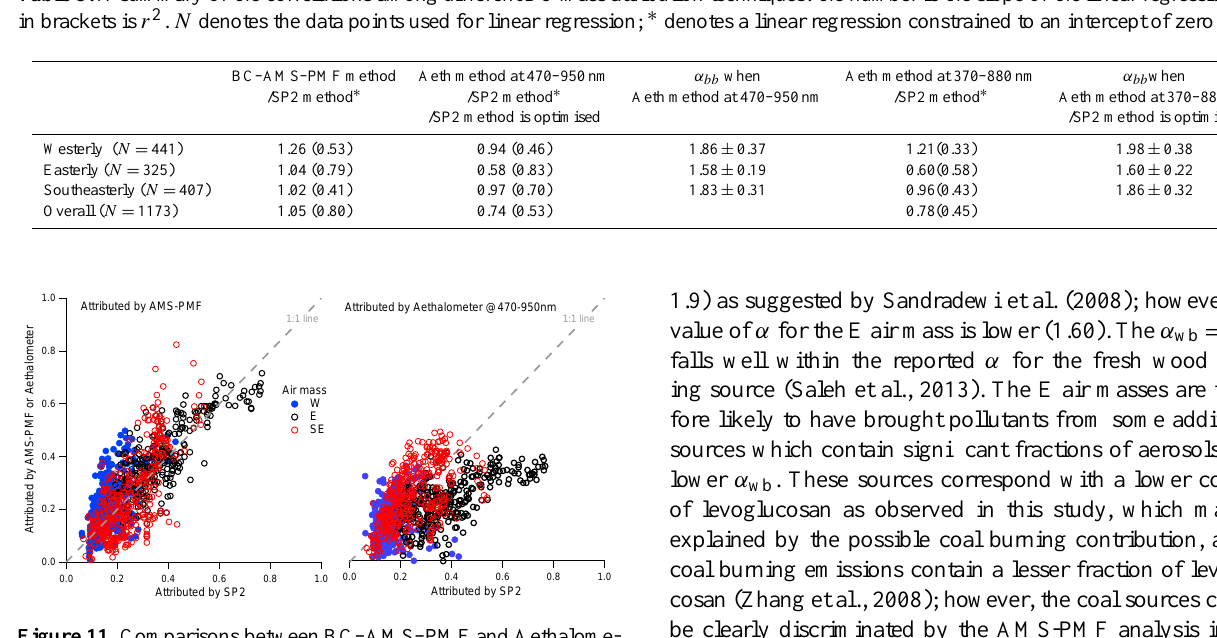
Figure 11. Comparisons between BC–AMS–PMF and Aethalome- ter ( λ 470–950nm ) attributed BC sf mass fraction and the SP2 attribu- tion for different air